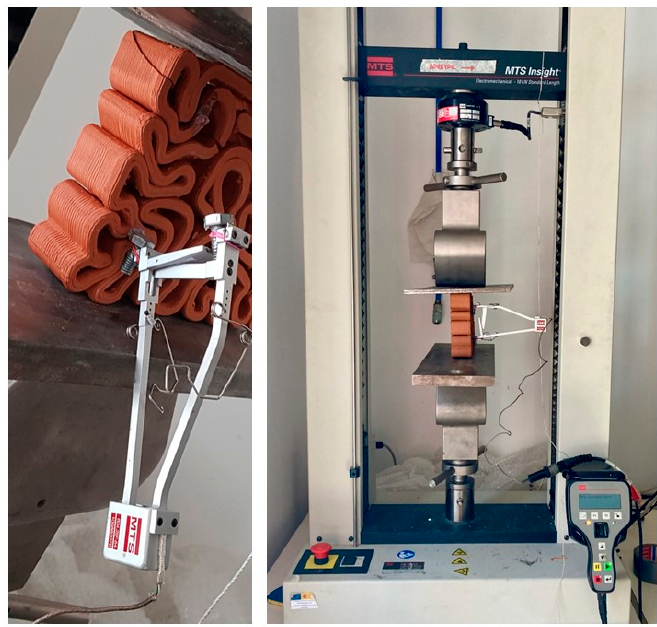
Figure 3. Showing the device used to apply the elasticity test of the 3DPBDCB, using the MTS Insight 10 kN electromechanical press. At the facilities of the CATMech-Litem research group (ESEIAAT School, UPC). (By